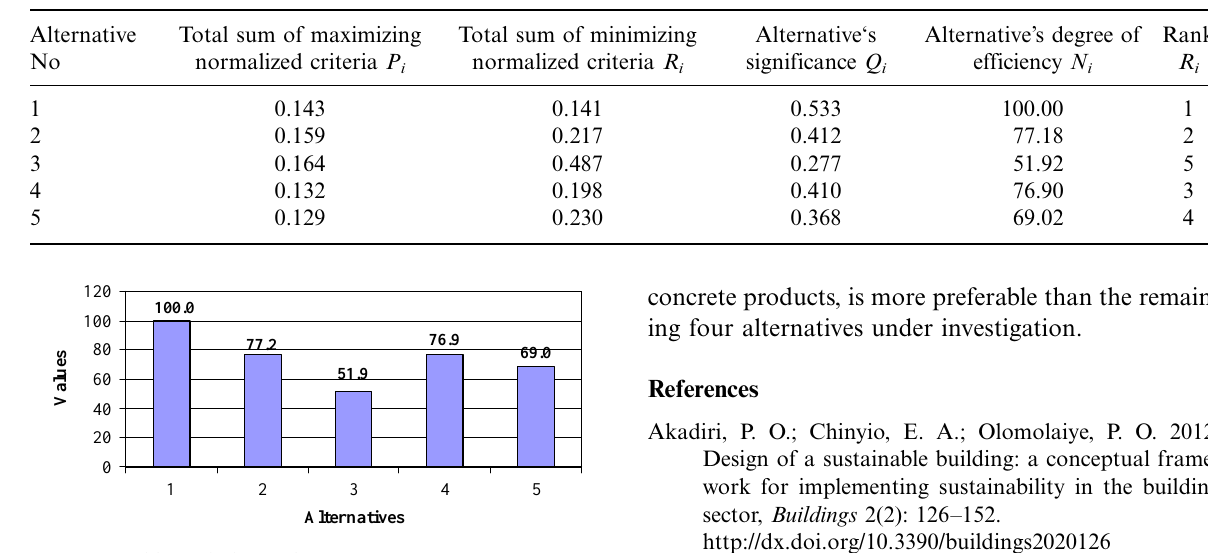
Fig. 5. Ranking of